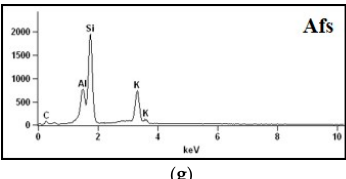
Figure 14. Fragment of the rock in the mortar submitted to the mortar bar test, where: Afs = K-feldspar, Pl = plagioclase, and Qz = quartz. ( a ) Micrograph obtained by optical microscopy under crossed polarizer of the rock showing voids because of the dissolved quartz, 5× magnification; ( b , c ) micrographs obtained in SEM detailing quartz not yet dissolved, 75× and 300× magnification; ( d – g ) spectra obtained by EDX from quartz, void, plagioclase, and K-feldspar.